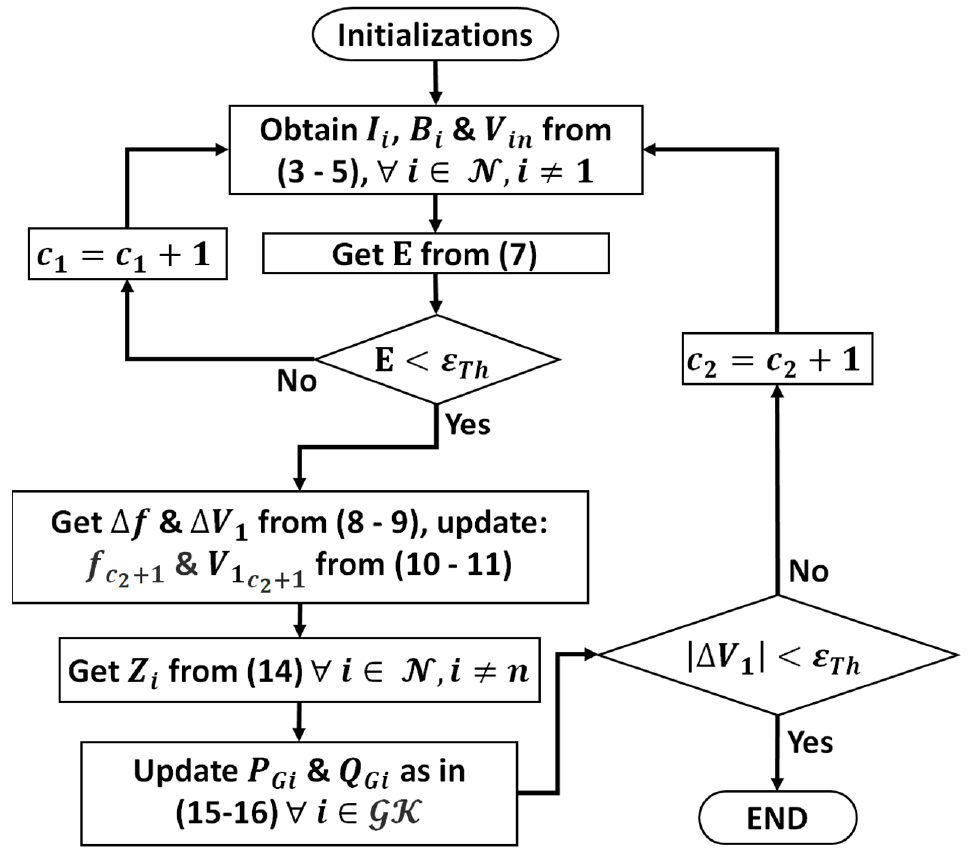
Figure 3. Special backward/forward sweep load flow